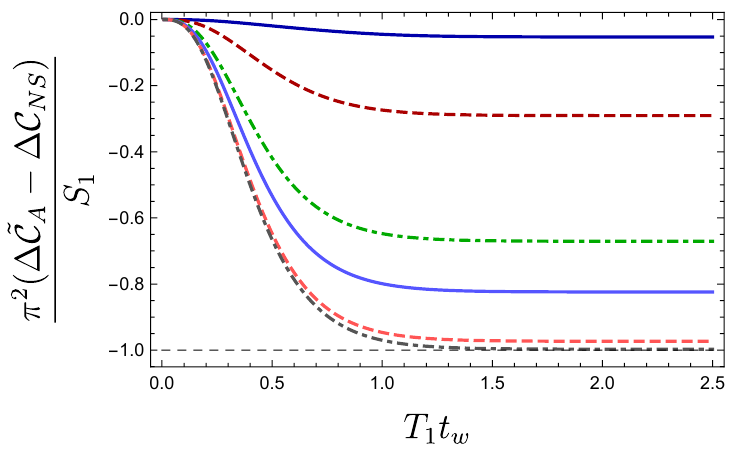
Figure 12. Complexity of Formation for BTZ black holes with no counterterm added to the null boundaries (and (cid:20) = 0). From top to bottom, we consider light to heavy shock waves, with w = 1+ 10 (cid:0) 2 , w = 1+10 (cid:0) 1 , w = 1 : 5, w = 2, w = 5 and w = 15. For T 1 t w of order 1, the complexity of